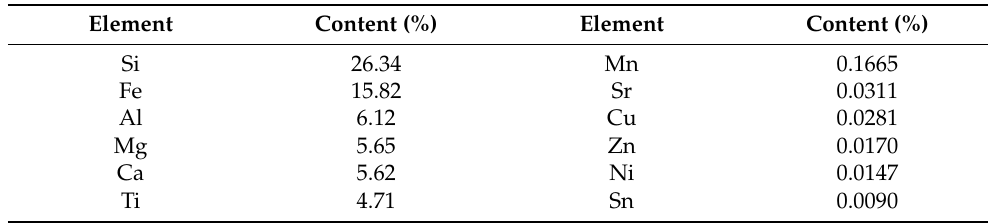
Table 2. Factor-level table of single-factor